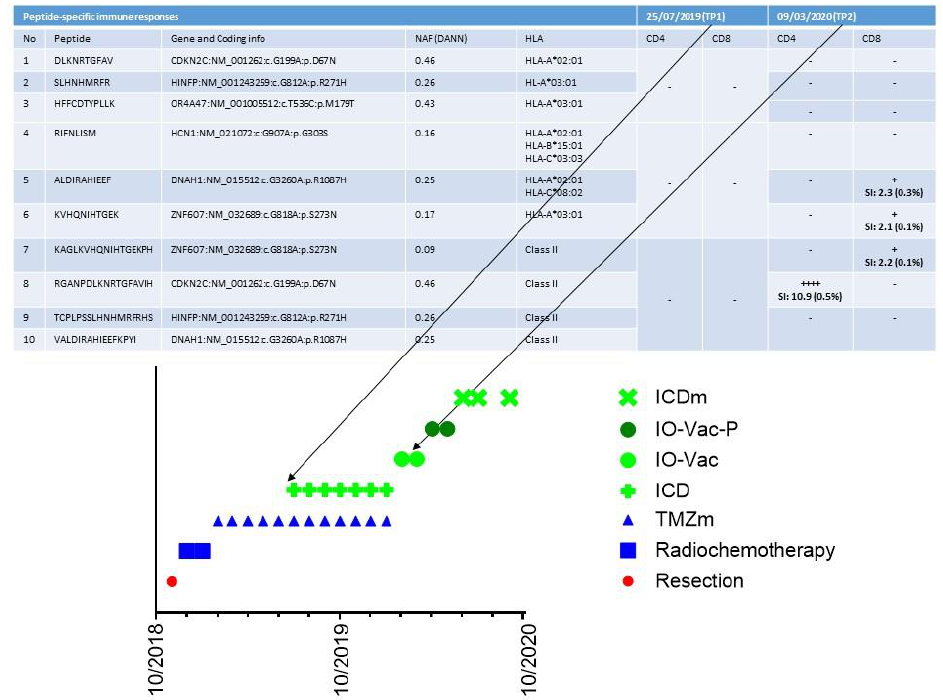
Figure 4. Detection of tumor-specific T-cell clones. The treatment timeline for patient 24442 and its multiple components are shown in the bottom part of the figure. TMZm indicates five days of temozolomide maintenance treatment in cycles (every 28 days). ICD indicates immunogenic cell death (ICD) treatment consisting of the combination of five injections with Newcastle Disease Virus and five sessions of modulated electrohyperthermia. IO-Vac indicates a vaccination cycle including six ICD treatments and an injection of IO-Vac ® DC vaccine, consisting of autologous mature dendritic cells loaded with ICD-treatment-induced, serum-derived, antigenic, extracellular microvesicles and apoptotic bodies. IO-Vac-P vaccination cycles are equal to IO-Vac vaccination cycles, but the DCs are loaded with tumor-specific neo-peptides. The upper part of the curve shows the specific peptide sequences, the respective gene and coding information, the Novel Allele Frequency (NAF), and the HLA phenotype. TP1 and TP2 indicate the two respective time points at which T-cells were frozen for immune monitoring purposes. SI is the stimulation index, the ratio of polyfunctional activated CD4+ or CD8+ T-cells (positive for at least two activation markers from CD154, IFN-g, TNF, and/or IL-2) in the peptide-stimulated sample, compared with the unstimulated control. Additionally, the percentage of activated CD4+ or CD8+ T-cells (positive for at least one activation marker of CD154, IFN-g, TNF, and/or IL2) above the background and after in vitro amplification is given. This percentage does not directly reflect the frequencies in vivo. SI ≥ 2: weak response (+); SI ≥ 3: